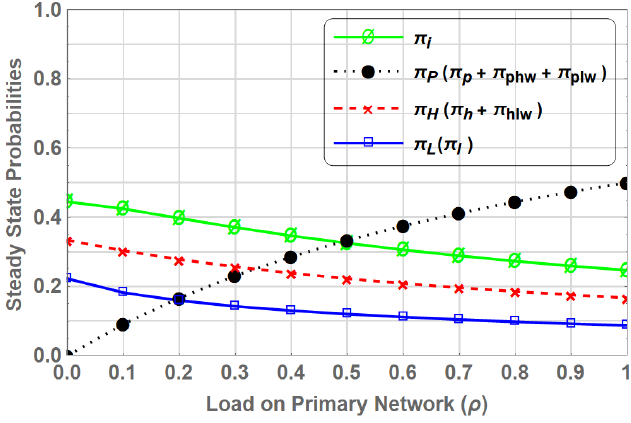
Figure 8. Stationary probabilities for PN-MC-IW.